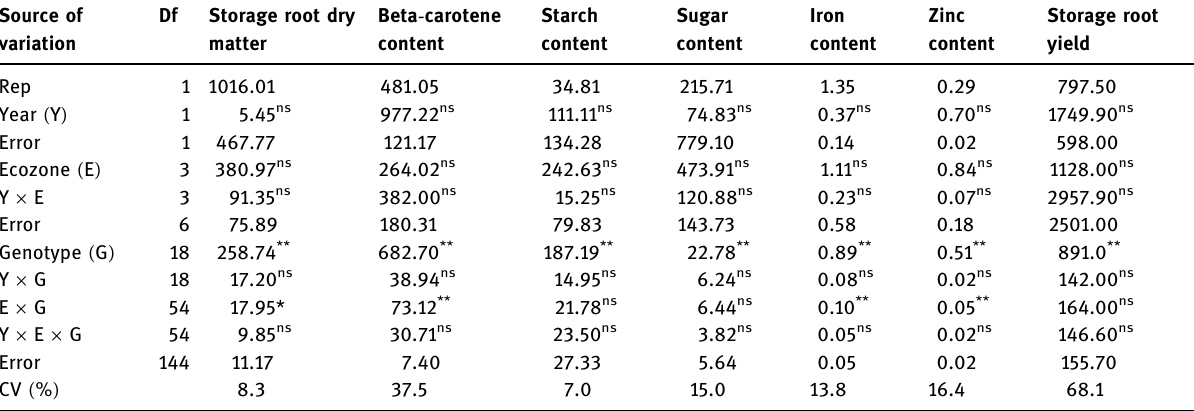
Table 3: Mean squares for storage root yield and quality traits of the 26 sweetpotato genotypes Source of Df variation